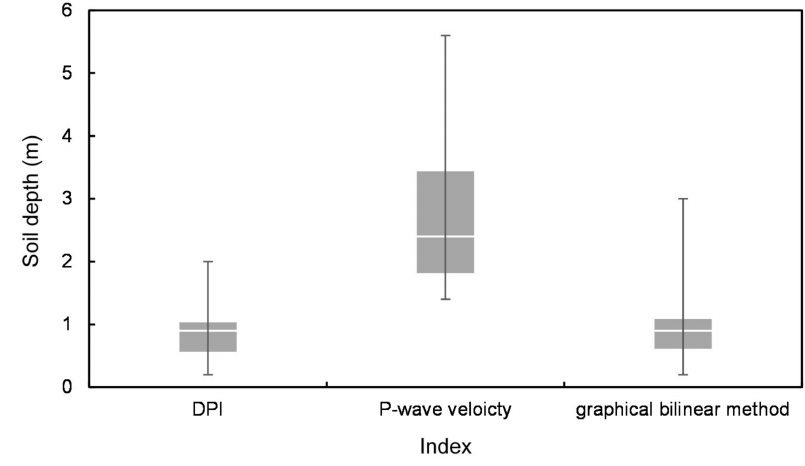
Figure 11. Comparison of soil depths through box